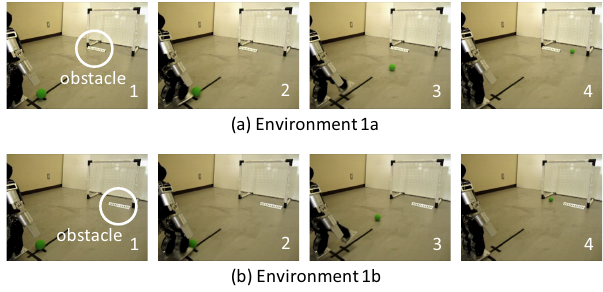
Figure 11. Experimental scenes of kicking motion in Environment 1 by the HOAP-3 calculated under fifty points of ball location from 2 . 5 cm to 5 cm. We can confirm that the computation time for the motions to kick a ball on the ground and in the air were less than two seconds when using the proposed method. The computation time was about 0.15 seconds for Step A , and about 0.5 seconds per one iteration for Step B . In the case of three iterations, the computation time of Step B becomes almost 1.7 seconds. Therefore, the robot can plan a feasible motion less than 2 seconds.